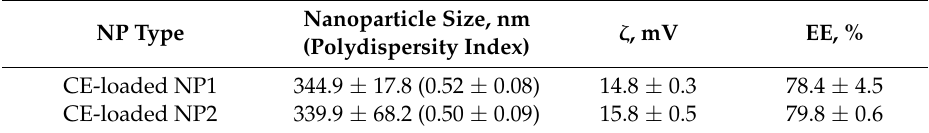
Table 1. Characteristics of nanoparticle (NP)-loaded cherry extract (CE).